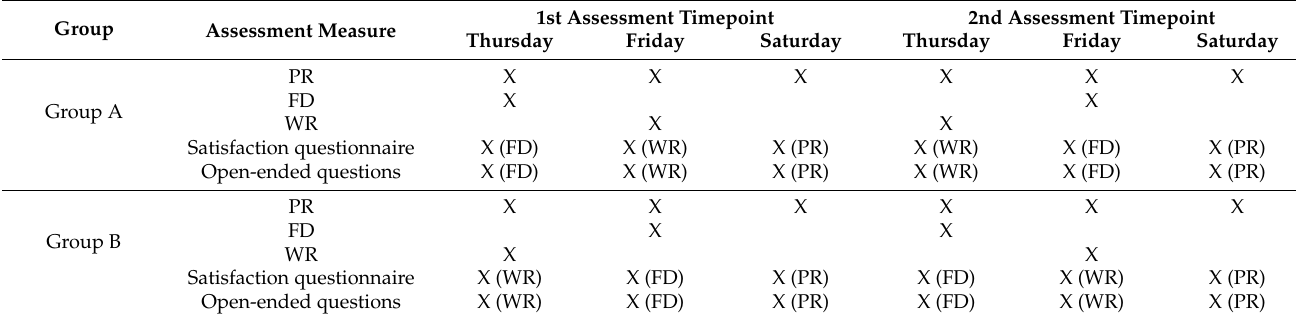
Table 1. Schedule for completion of dietary assessment and satisfaction